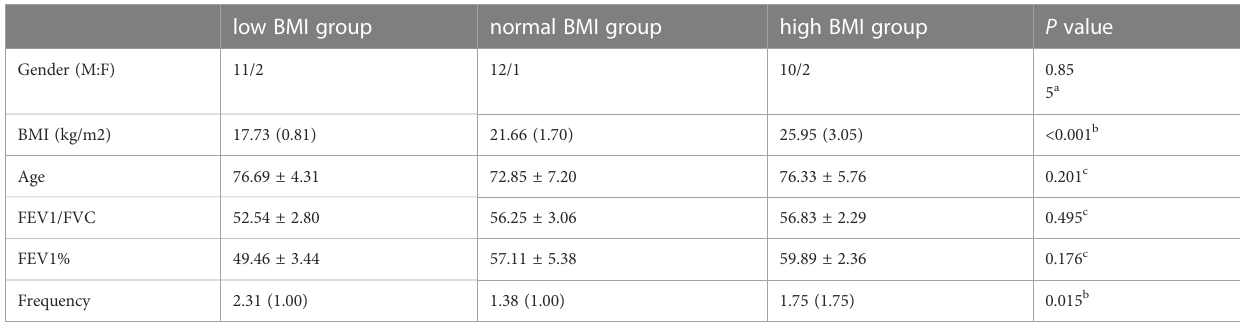
TABLE 1 Comparison of general clinical data of patients in different BMI